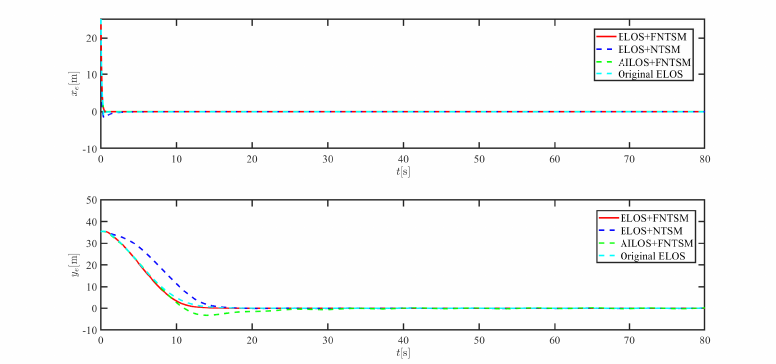
Figure 10. Comparison results of straight line trajectory tracking at fast speed.